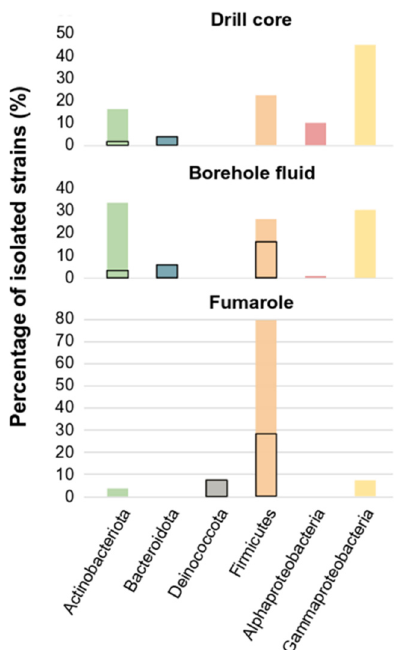
Figure 1. Taxonomical distribution at the phylum level (classes for Proteobacteria) of the bacterial isolates from Surtsey island by sampling sites. The percentages represent the relative cultivable bacterial abundance. Thermophilic strains ( ≤ 60 °C) are framed in bold.